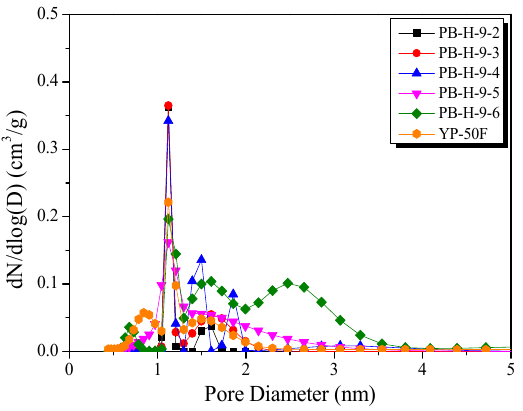
Figure 2. Pore size distributions obtained using the NLDFT method of the bamboo-derived activated carbon as a function of steam activation conditions.